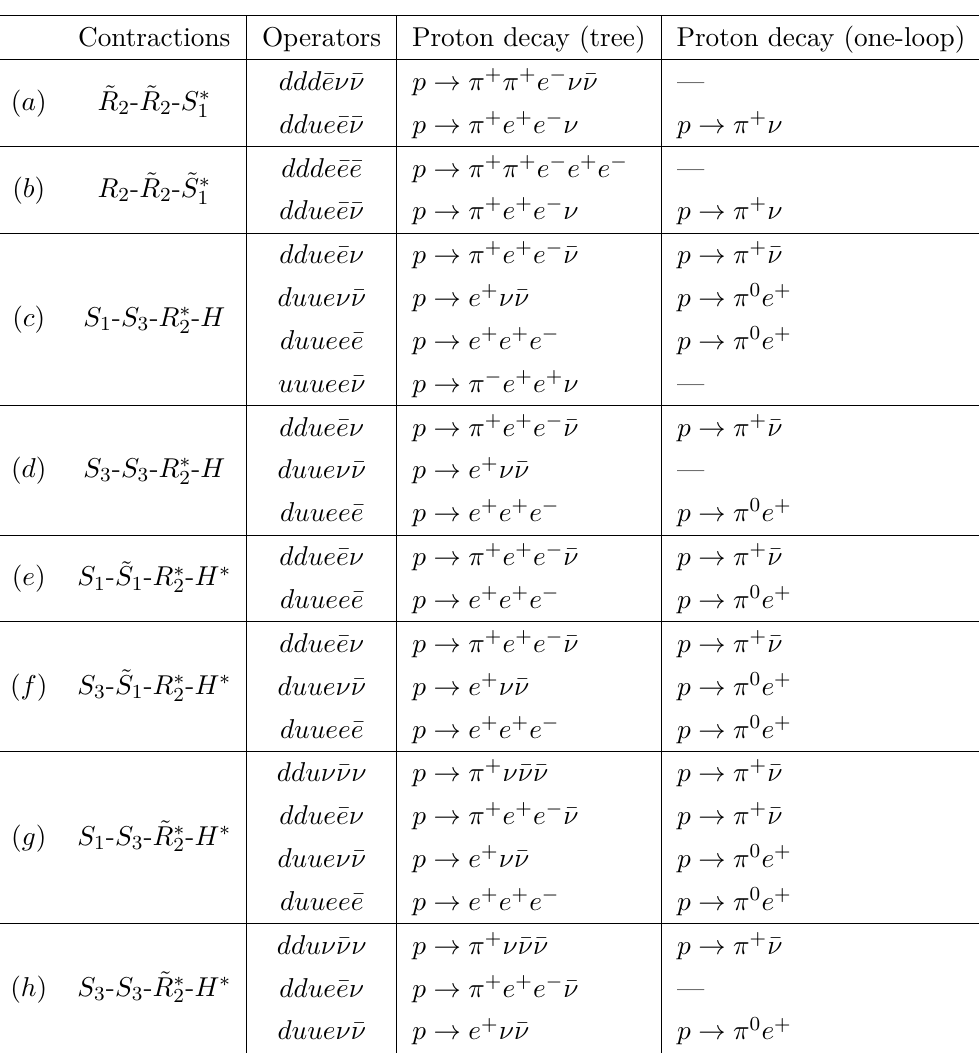
Table 3 . List of all non-trivial ∆ - ∆ 0 - ∆ 00 and ∆ - ∆ 0 - ∆ 00 - H contractions, schematic representation of the associated d = 9 effective operators, and corresponding proton decay channels at both the tree- and one-loop levels. The effective operators in scenarios ( a ) and ( b ) conserve B + L , while the ones appearing in the remaining scenarios conserve B − L , where B and L are baryon and lepton numbers,